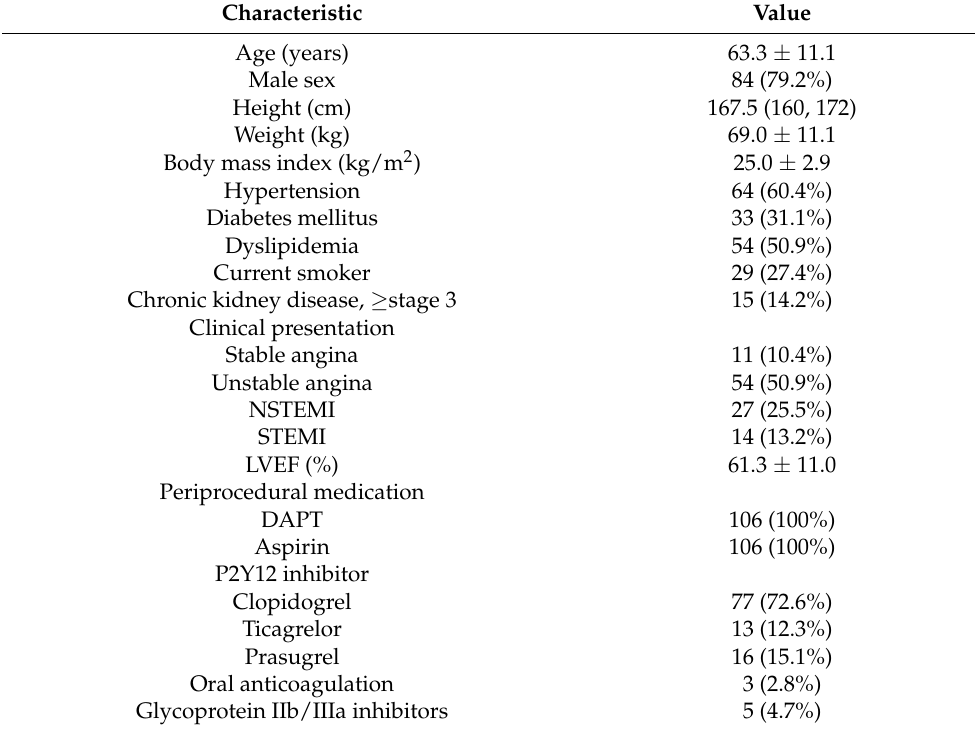
Table 1. Baseline characteristics ( n = 106).